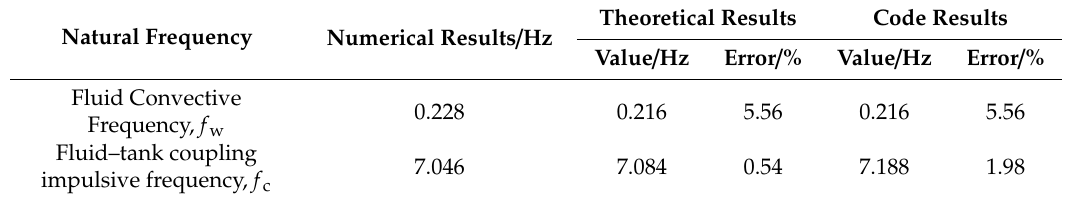
Table 1. Comparison of the natural frequency by a numerical solution and other literature.